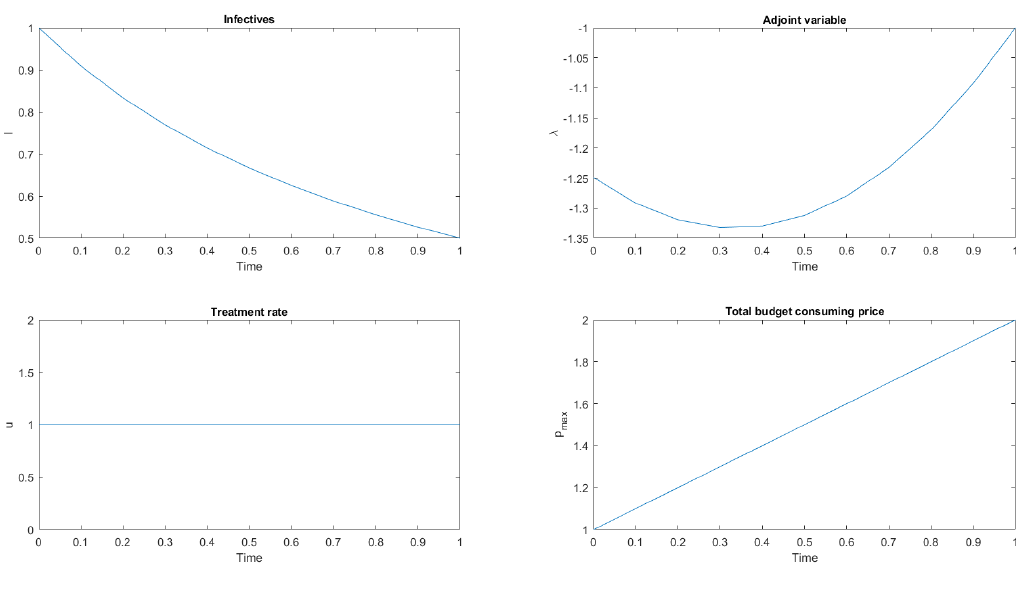
Figure 1. Cooperative solution. Linear cost. B = 1.